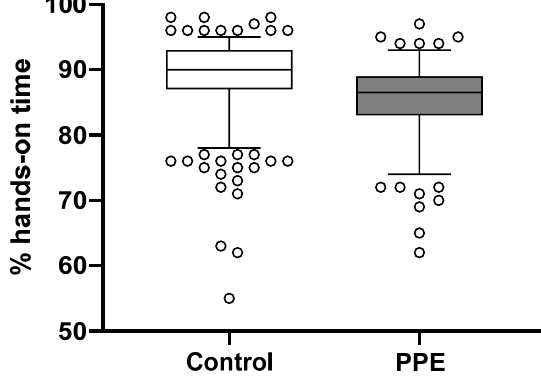
Figure 1. Box and whisker plot of the percentage hands-on time. Boxes represent medians and interquartile range; whiskers delineate the 5th and 95th percentile respectively. Outlier markers indicate teams performing outside the 5th and 95th percentile. White box = control group (no PPE); grey box = group performing CPR with PPE. Hands-on times differed significantly between the groups ( p < 0.0001).